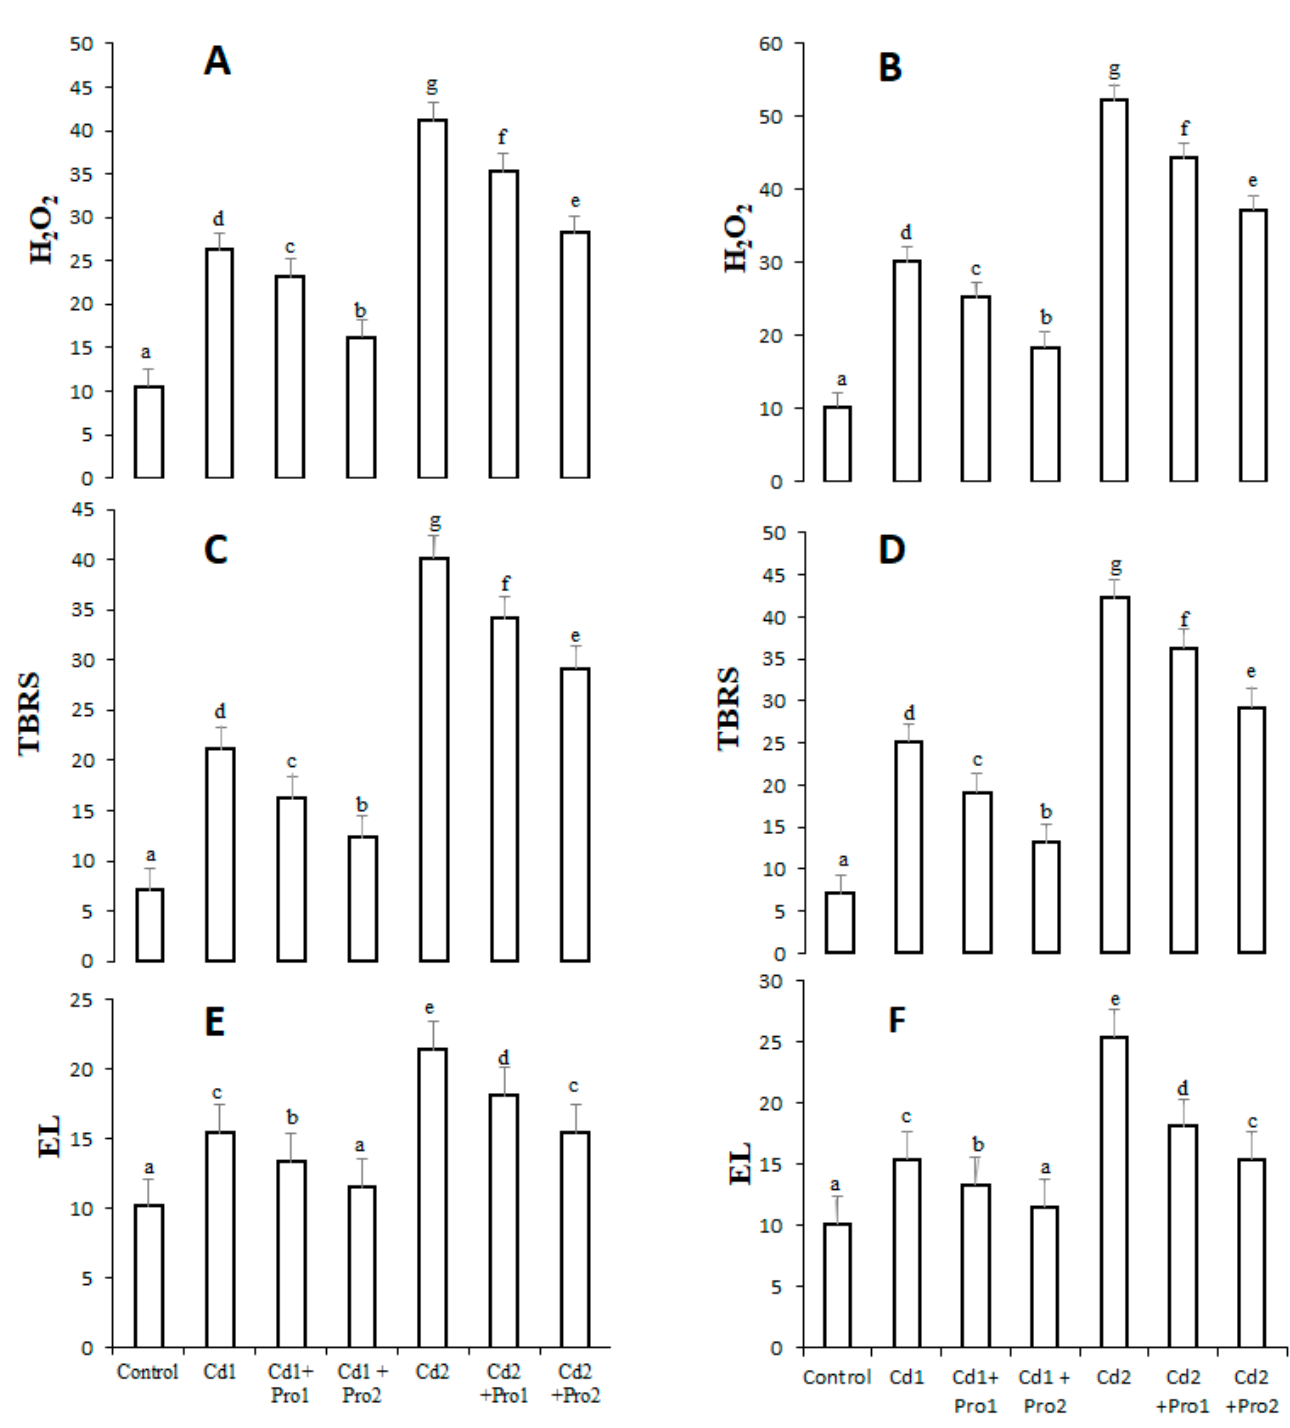
Figure 1. Hydrogen peroxide (H 2 O 2 , mmol g − 1 FW) and lipid peroxidation (TBRS) contents (mmol g − 1 FW), and electrolyte leakage (EL%) in the leaves ( A , C , E ) and the roots ( B , D , F ) of pigeon pea exposed to different Cd and exogenous proline treatments. Bars represent the mean of three replicates ± SD. Cd 1 (4 mg), Cd 2 (8 mg), Cd 1 + Pro 1 (4 mg Cd + 3 mM proline), Cd 1 + Pro 2 (4 mg Cd + 6 mM proline), Cd 2 + Pro 1 (8 mg Cd + 3 mM proline), Cd 2 + Pro 2 (8 mg Cd + 6 mM proline). Different small letters show significant differences, and the same small letters show non-significant differences according to Duncan’s multiple range test ( p ≤ 0.05).